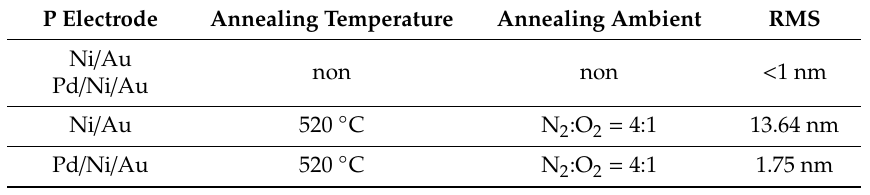
Table 3. The Atomic Force Microscope (AFM) results of Ni/Au and Pd/Ni/Au films. P electrode